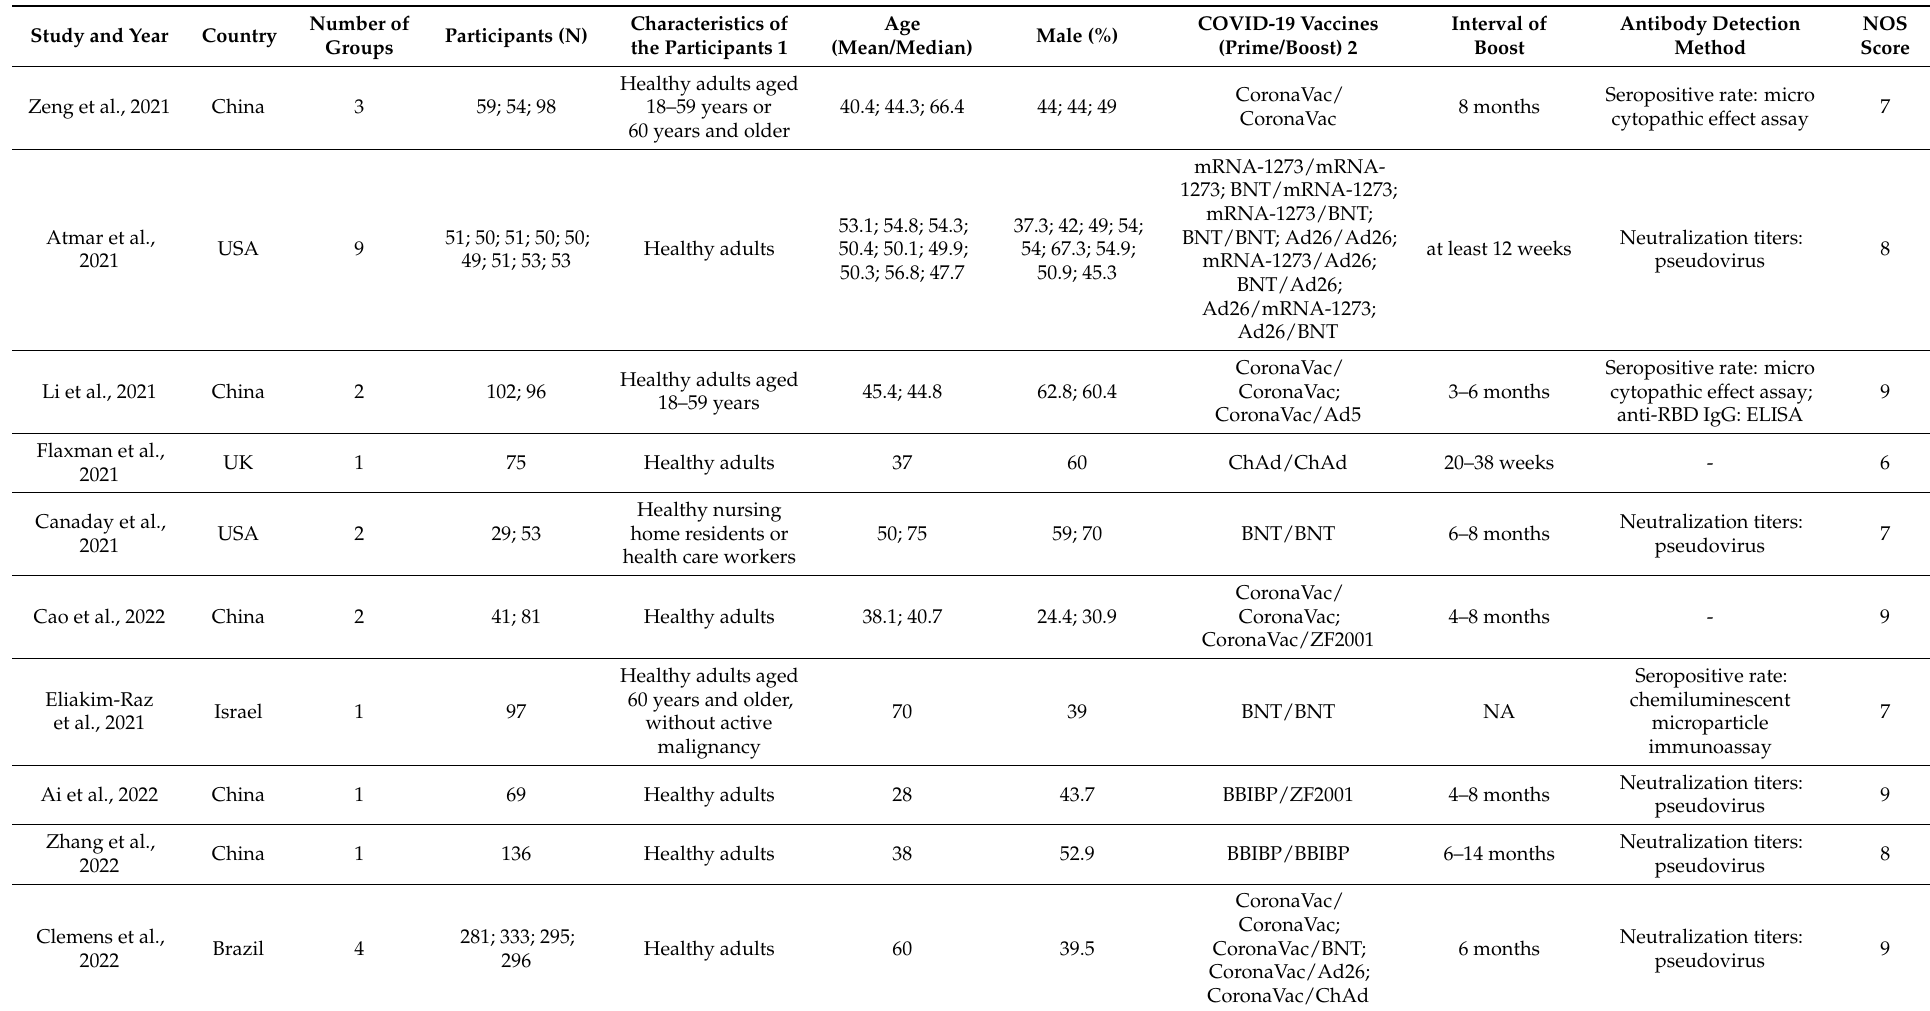
Table 1. Characteristics of the original studies included in the